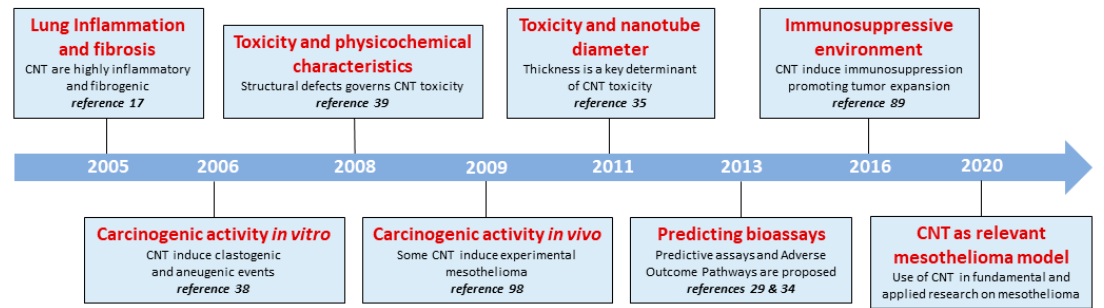
Figure 1. Historical progression of CNT-induced toxicity. Timeline summarizing the discoveries on CNT toxicity obtained by LTAP teams (UCLouvain, Brussels, Belgium) and their scientific collaborators from around the world. For this collective work, we used diverse and relevant in vivo and in vitro models and CNT possessing diverse morphological and physico-chemical